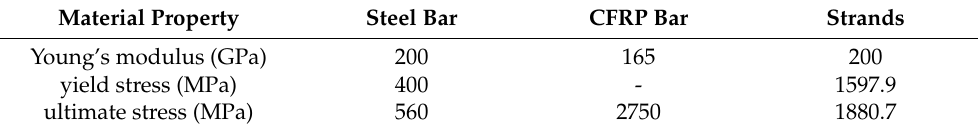
Table 3. Material properties of steel, carbon fiber-reinforced polymer (CFRP), and